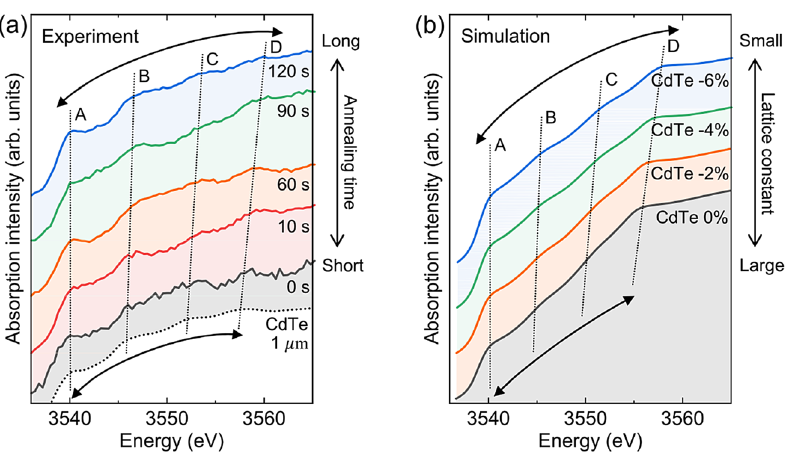
Figure2: (a)Cd L 3 -edgeXANESspectraof theCdTeQDsannealedfordifferenttimes.(b)The XANESsimulationresults(FEFF8)foracubicCdTe with various ratios of reduction in Cd – Te bond lengths. Dotted lines A, B, C, and D are visual guides emphasizing the evolution of the separations of the oscillatory features. QD, quantum dot; XANES, X-ray absorption near-edge